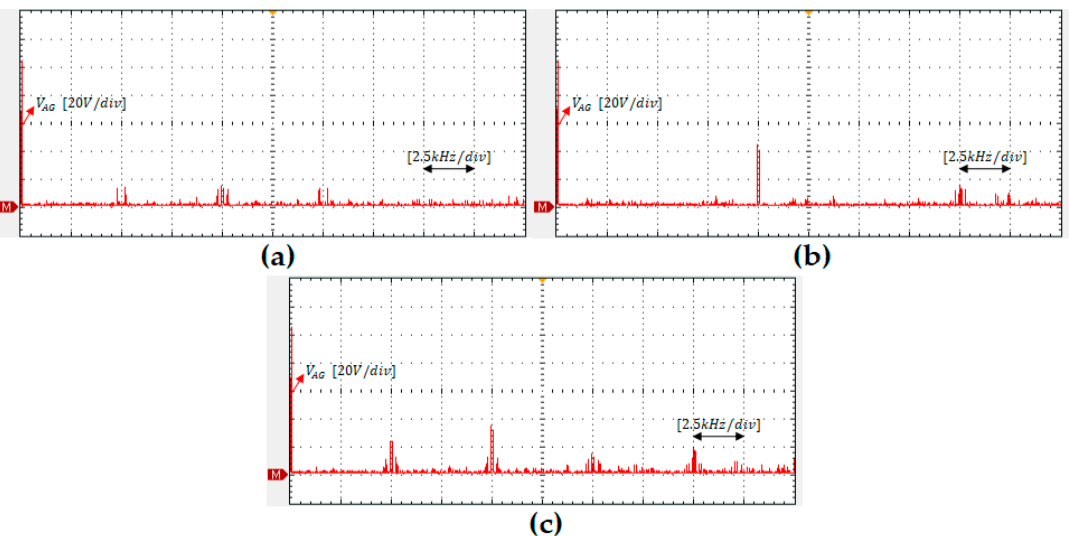
Figure 14. Experimental results of THD analysis of output phase voltage ( V AG ). ( a ) Method 1, ( b ) method 2, ( c ) proposed method.